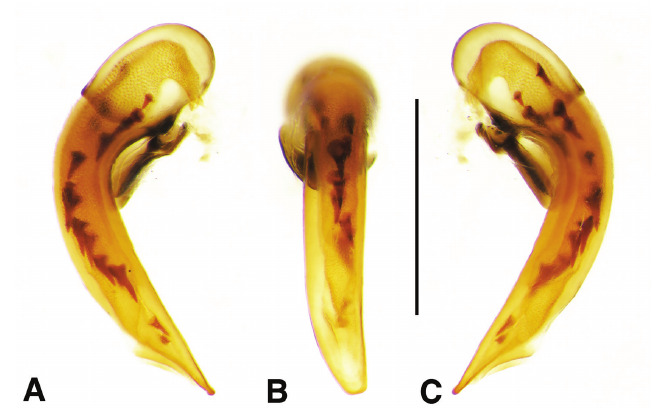
Figure 59. Digital images of male genitalia of Selenophorus striatopunctatus species group, S. striatopunctatus Putzeys. A right lateral aspect B dorsal aspect C left lateral aspect. Scale bar 1 mm.